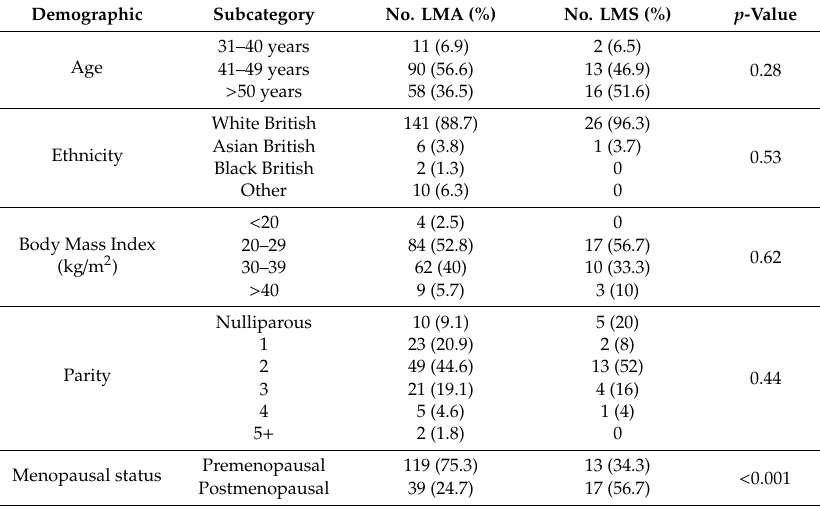
Table 2. Patient demographic variables between leiomyoma and LMA